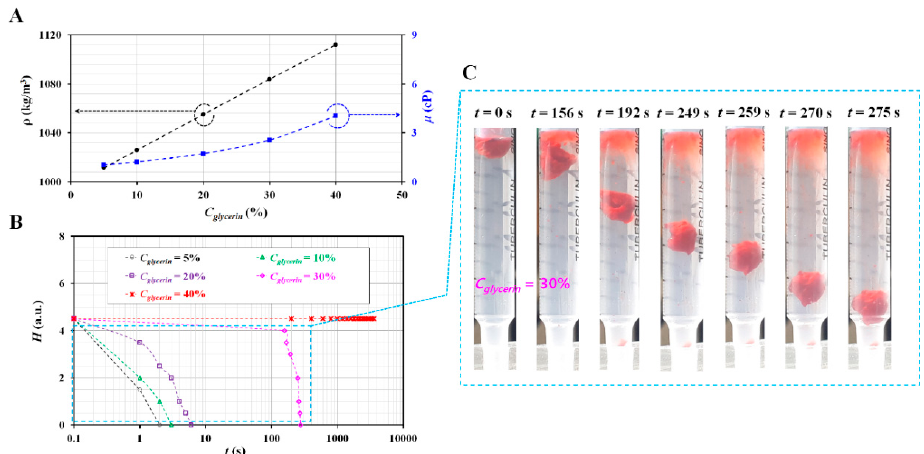
Figure A3. Selection of proper reference fluid by quantifying density ( ρ ) and sedimentation of RBCs droplet with respect to C glycerin = 5%, 10%, 20%, 30%, and 40%. ( A ) Variations of ρ and viscosity ( μ ) with respect to C glycerin . ( B ) Temporal variation of sedimentation height ( H ) with respect to C glycerin . ( C ) Snapshots for showing sedimentations of RBCs droplet with elapsed time ( t ) ( t = 0, 156, 192, 249, 259, 270, and 275 s). Here, the syringe was filled with a 30% glycerin solution.